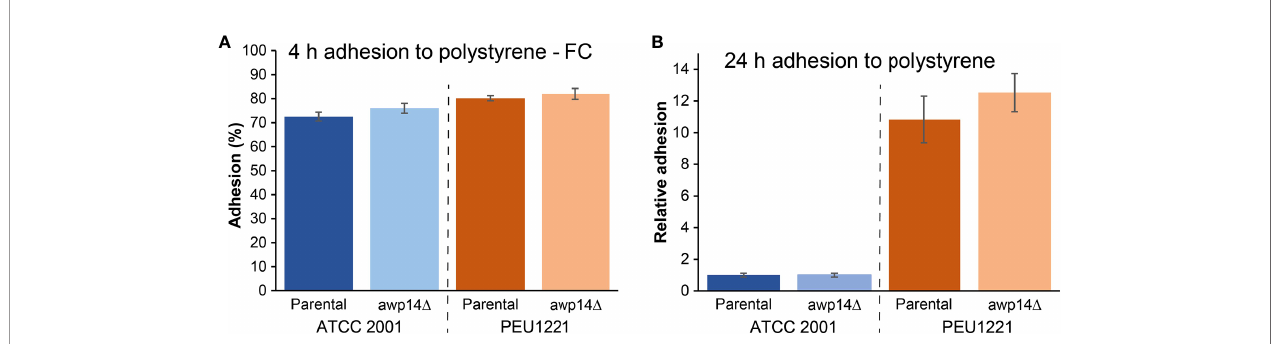
FIGURE 1 | Awp14 is not responsible for the HBF phenotype of PEU1221. (A) Adhesion to polystyrene after 4 h measured by fl ow cytometry (FC). (B) Bindingto polystyrene after 24 h measured by Crystal violet (CV) staining. AWP14 was deleted andanalyzed in two genetic backgrounds: reference strain ATCC 2001